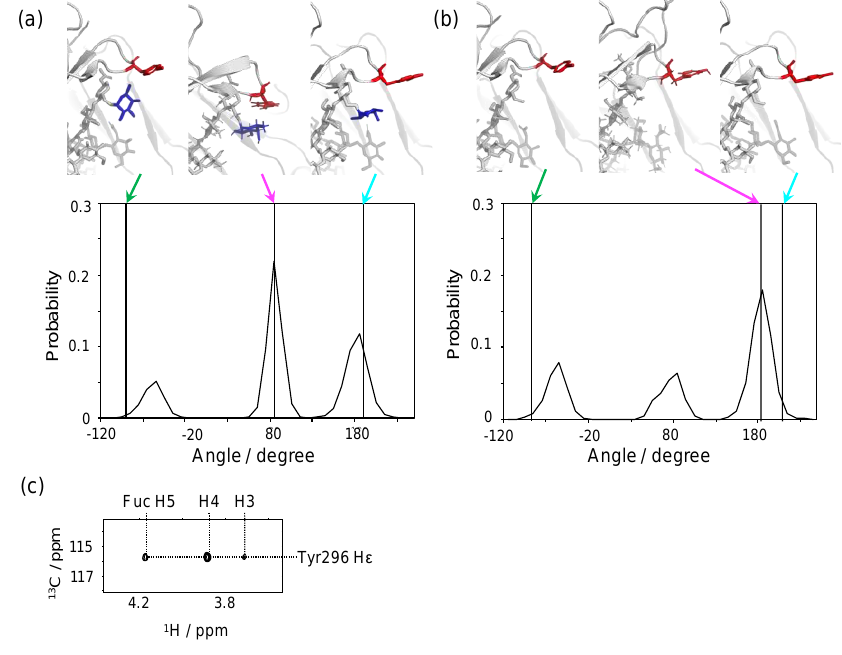
Figure 5. Conformational dynamics of the side chain of Tyr296 of IgG1-Fc depending on the core fucosylation. Distributions of χ 1 dihedral angles of Tyr296 in the ensemble models derived from MD simulations are plotted for ( a ) fucosylated IgG1-Fc and ( b ) non-fucosylated IgG1-Fc. The typical conformational snapshots of derived from the major conformational states (magenta arrows) in the simulation trajectory are shown along with the crystal structures used for building the starting models (green arrows; A, 3AVE; B, 2DTS) and those of sFc γ RIIIa-bound Fc (cyan arrows; A, 5XJE; B, 3AY4). ( c ) 2D HSQC-NOESY spectrum of IgG1-Fc labeled with [CO, α , β , γ , ε 1, ε 2- 13 C 6 ; β 2, δ 1, δ 2- 2 H 3 ; 15 N] tyrosine.